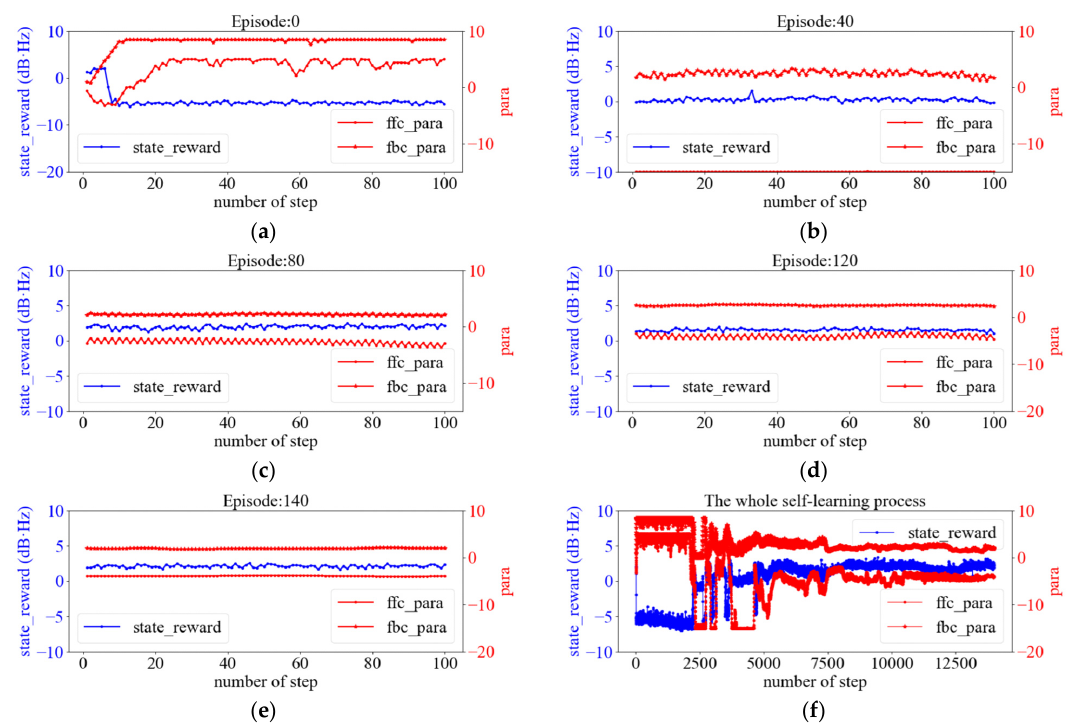
Figure 13. Experimental results of multi-parameter self-learning in DDPG: ( a – e ) are the learning curves of the 0/40/80/120/140th episode, respectively; ( f ) are the curves of the whole self-learning process.